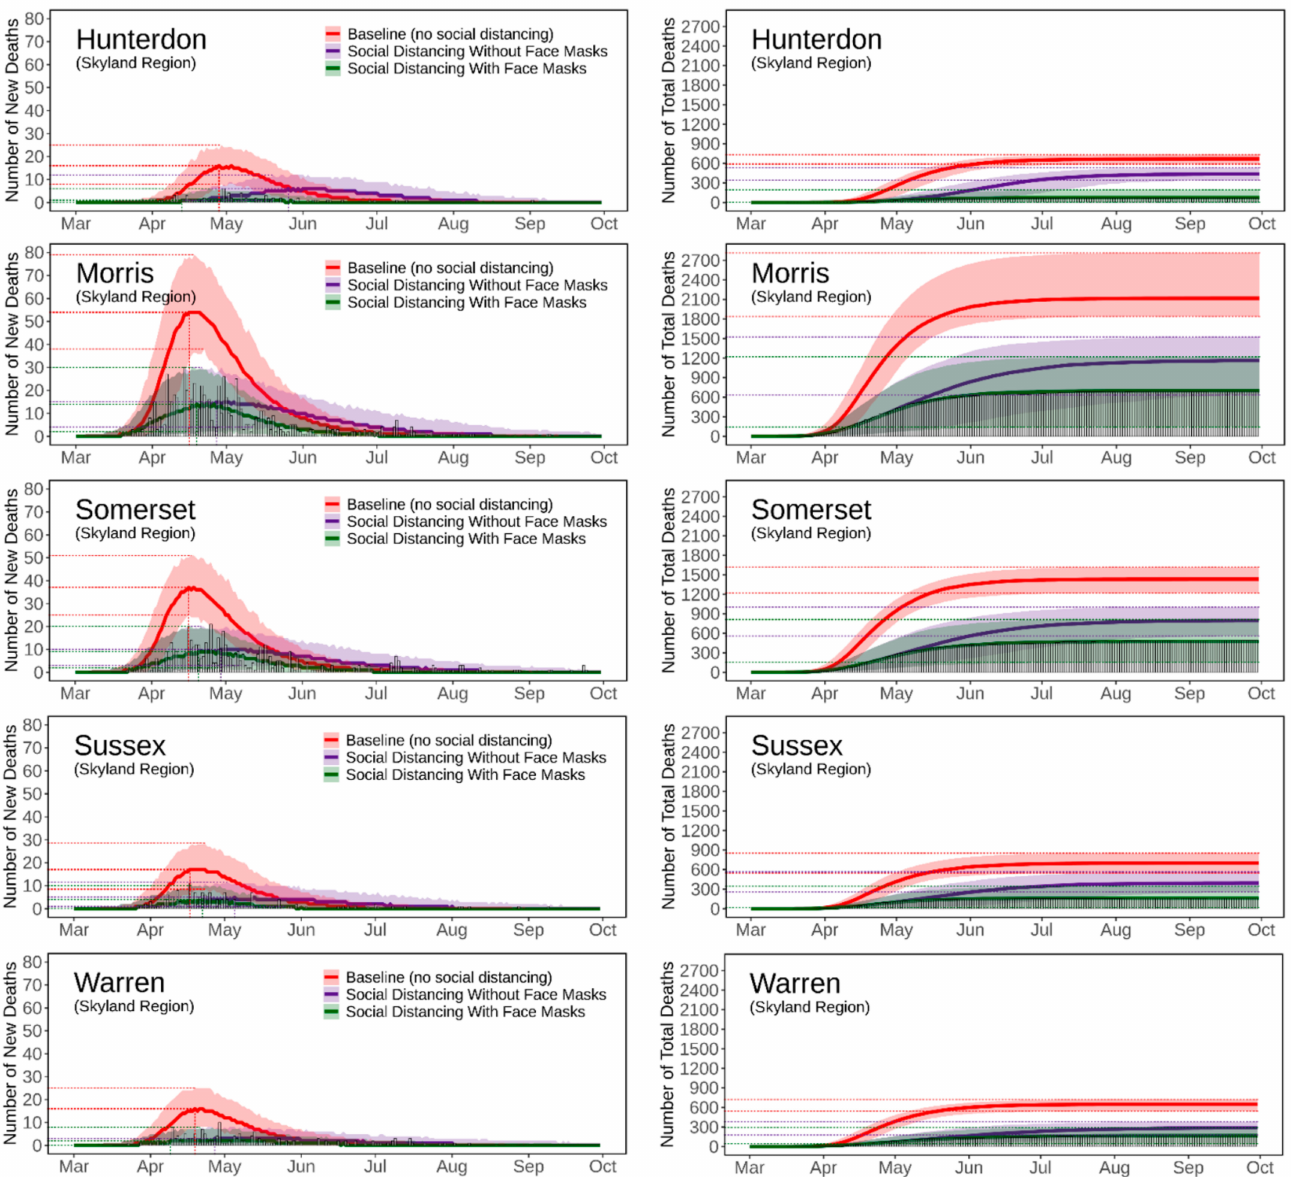
Figure 7. Predicted trajectories of new/total confirmed deaths from COVID-19 corresponding to three exposure scenarios for the counties in the Skyland Region of NJ, March to September 2020, compared with reported death data (vertical bars). The color-shaded areas depict the 95% Confidence Interval (CI) of the corresponding